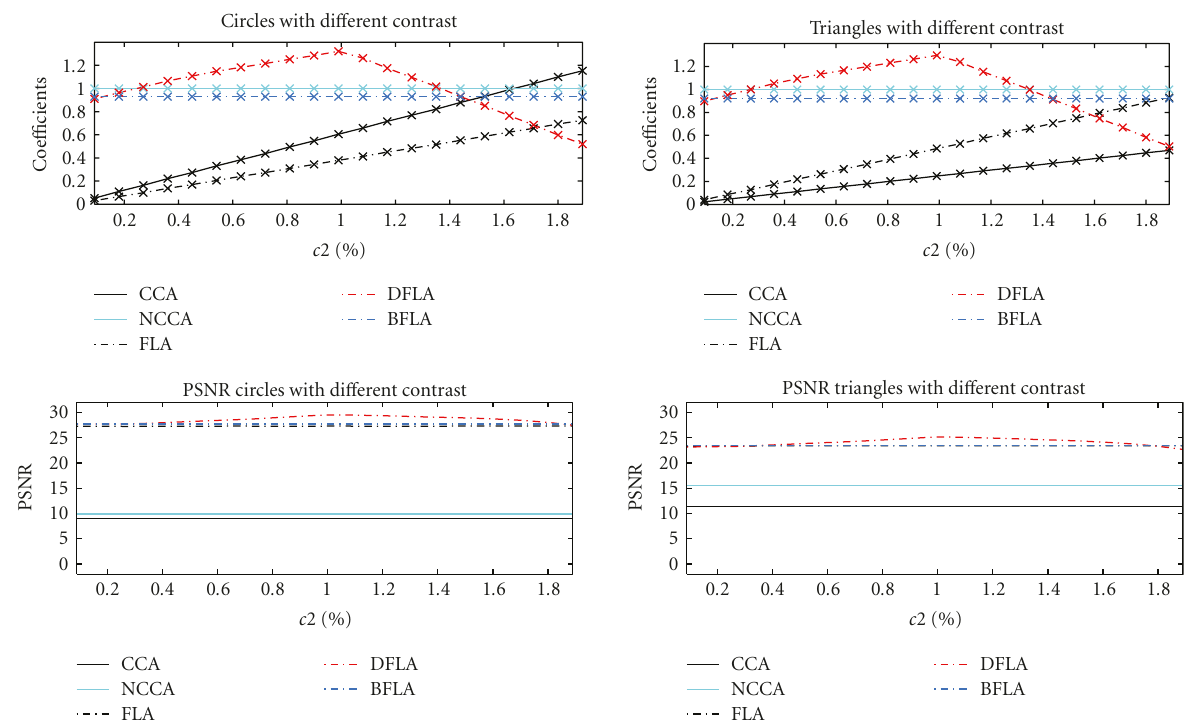
Figure 6: Influence of changes in contrast on the coe ffi cients and the PSNR of the cross-correlation algorithms (change of c 2 in percent (16)). Top: coe ffi cients of the cross-correlation algorithms, (marker—correct position found); bottom: PSNR of the cross-correlation algorithms; left: results of the circles; right: results of the